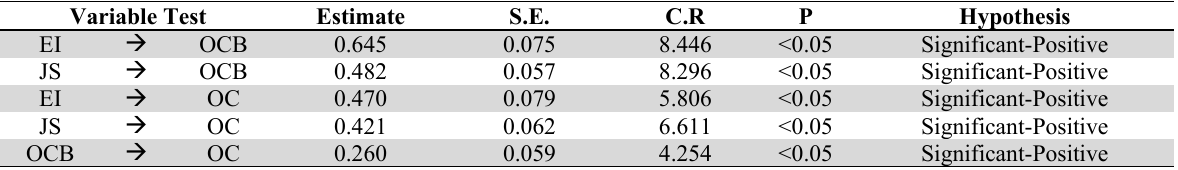
Test Results between Variable Effects